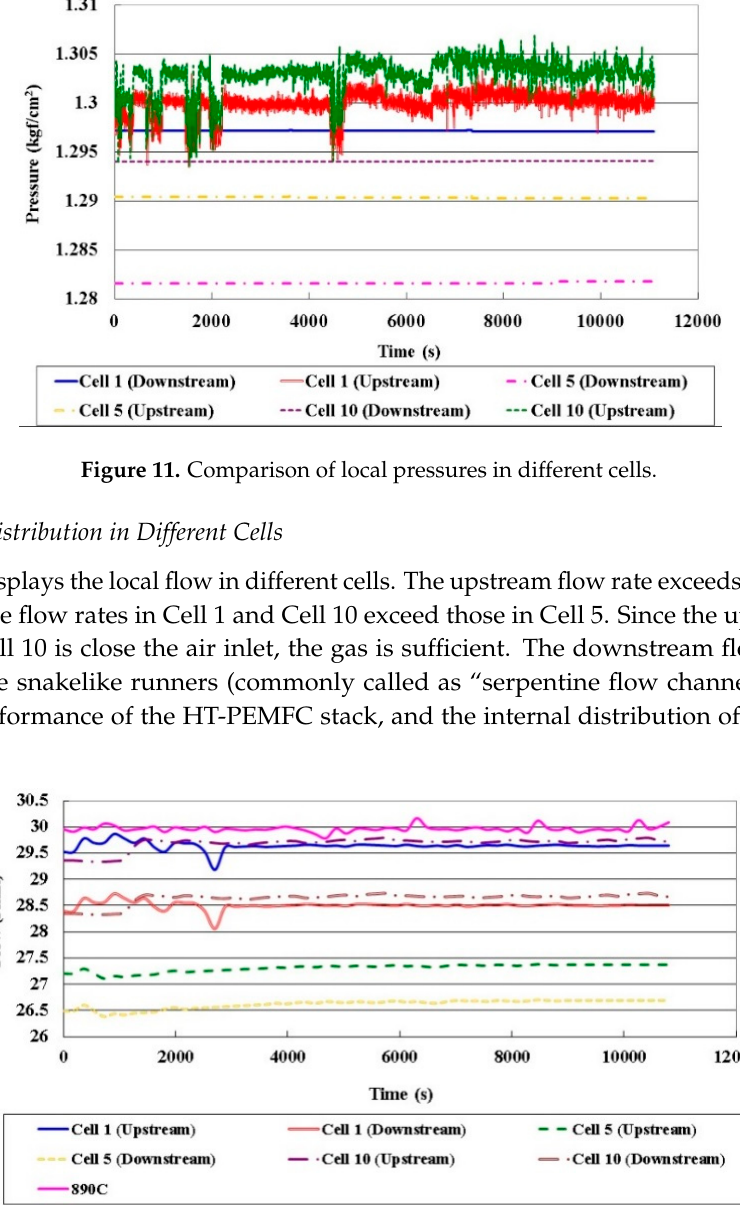
Figure 12. Comparison of local flow rates in different cells.